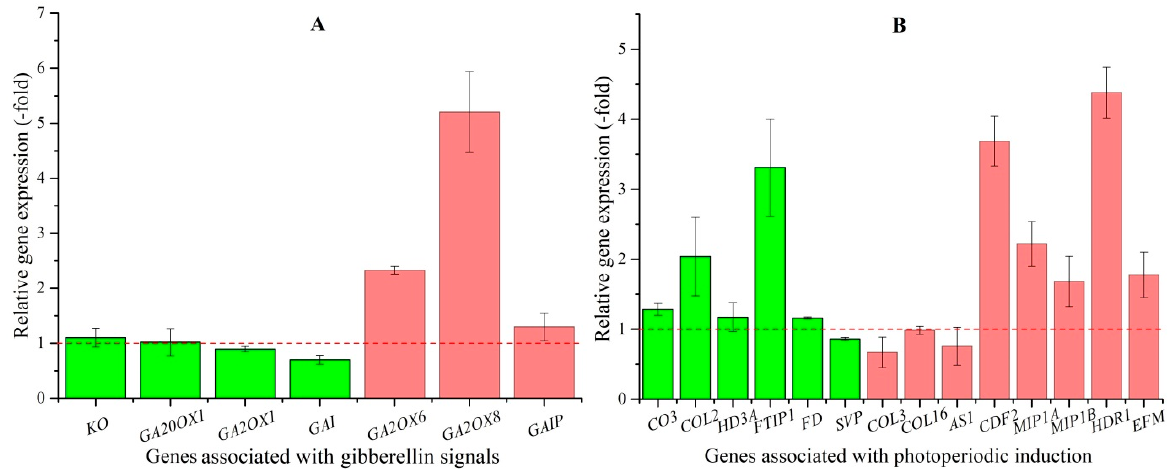
Figure 3. The relative expression level of genes associated with GA ( A ) and photoperiodic pathways ( B ) in bolted compared with unbolted plants, as determined by qRT-PCR. Column highlighted in green represents genes favoring flowering and red represents genes disfavoring flowering.